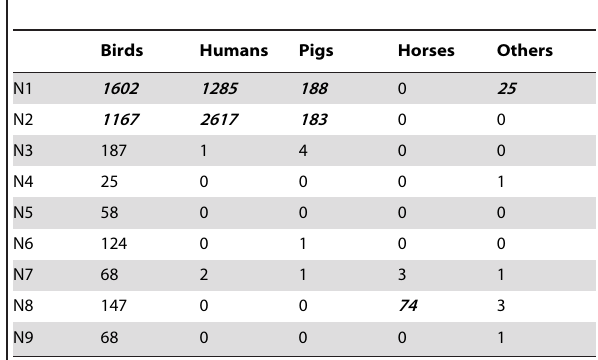
Table 4. Host distribution of 7836 influenza A viruses with NA sequences in GenBank*